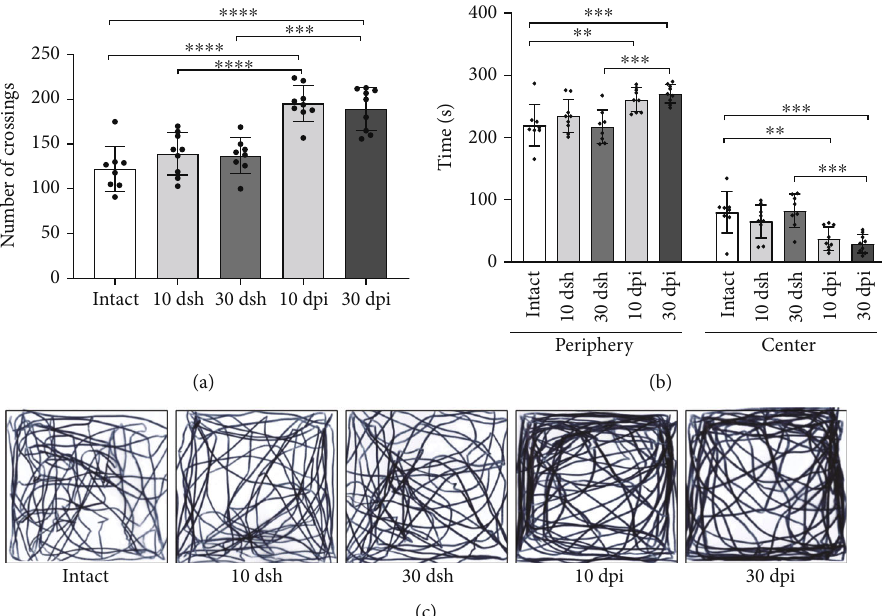
Figure 4: Mice at 10 dpi and 30dpi show increased motility and anxiety-like behavior. (a) Motor behavior was evaluated through the number of crossings. KA-injected mice at 10 and 30dpi show a higher number of crossings than intact and sham mice (one-way ANOVA followed by a Bonferroni ’ s post hoc test, F ð = 18 : 58 , p < 0 : 0001 ). (b) Anxiety-like behavior was evaluated through the time 4,38 Þ spent in the periphery and center zones of the fi eld. KA-injected mice at 10 and 30dpi spent more time on periphery and less time on = 16 : 44 , p < center zones than intact and sham mice (two-way ANOVA followed by a Bonferroni ’ s post hoc test, interaction F ð 4,76 Þ 0 : 0001 ). (c) Representative path length tracks from a mouse from each group are shown. The columns represent the mean with SD from each group. Dots superimposed in the graph represent individual values. Asterisks indicate statistically signi fi cant di ff erences ( ∗ p ≤ 0 : 05 ; ∗∗ p < 0 : 01 ; ∗∗∗ p < 0 : 001 ; ∗∗∗∗ p < 0 : 0001 ). Intact n = 8 ; 10dsh n = 9 ; 30 dsh n = 8 ; 10dpi n = 9 ; 30dpi n = 9